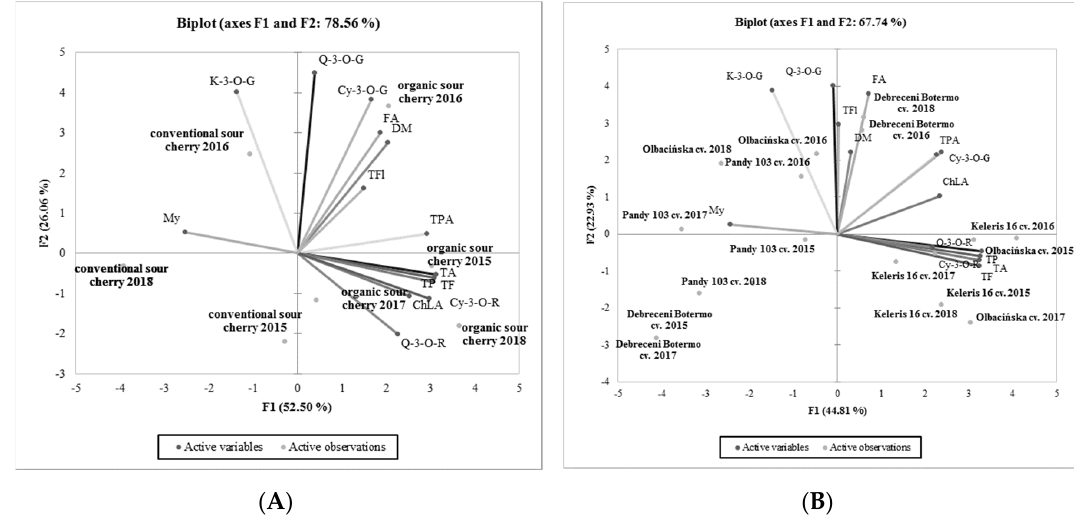
Figure 1. Principal component analysis (PCA) analysis showing the relationship between the polyphenols composition and ( A ) cultivation systems as well examined ( B ) cultivars of sour cherry in 2015–2018. Dry matter (DM,) total polyphenols (TP), total phenolic acids (TPA), ferulic acid (FA), chlorogenic acid (ChLA), total flavonoids (TF), total flavonols (TFl), quercetin-3- O -rutinoside (Q-3- O - R), quercetin-3- O -glucoside (Q-3- O -G), kaempferol-3- O -glucoside (K-3- O -G), myrycetin (My), total anthocyanins (TA), cyanidin-3- O -rutinoside (Cy-3- O -R), cyanidin-3- O -glucoside (Cy-3- O